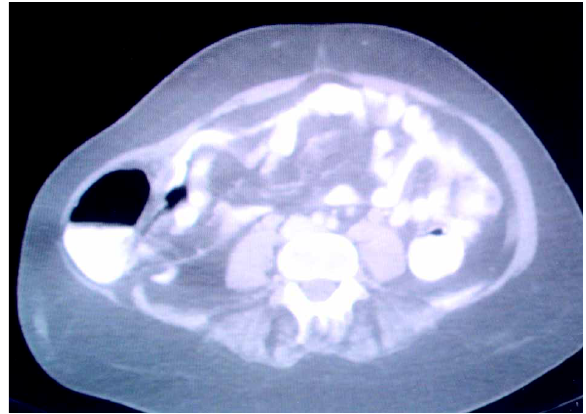
Figure 1 – Computerized tomography showing the abdominal wall defect in the lumbar